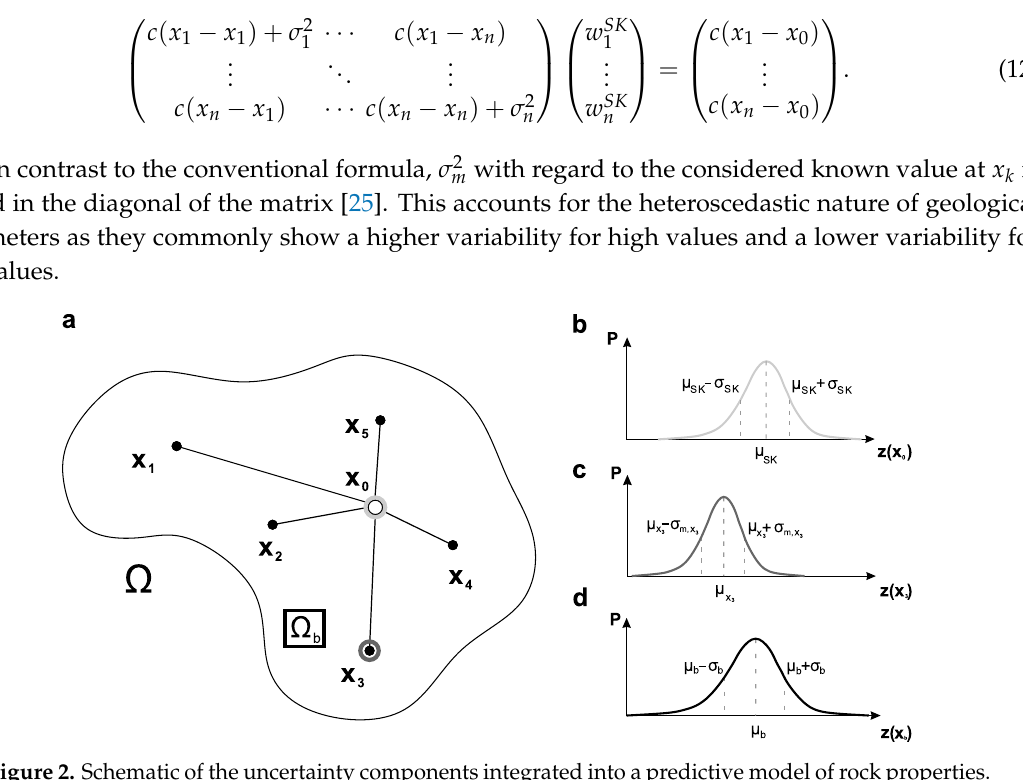
at x 0 ( b ), the SK in a subset Ω b of Ω ( d b